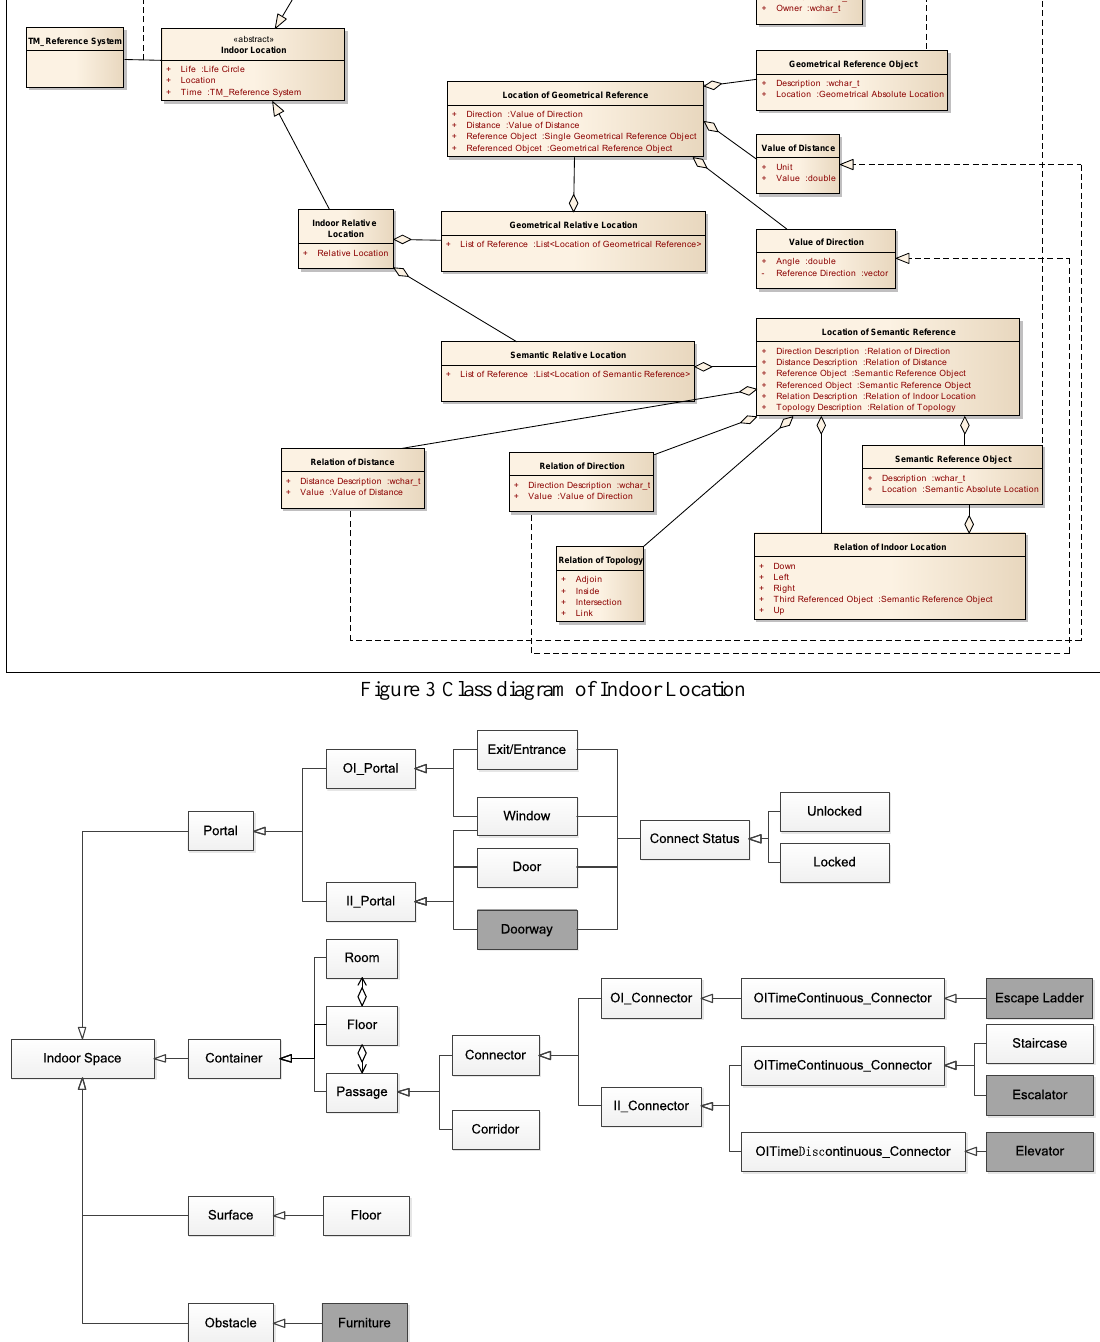
Figure 4 The structure defining of building